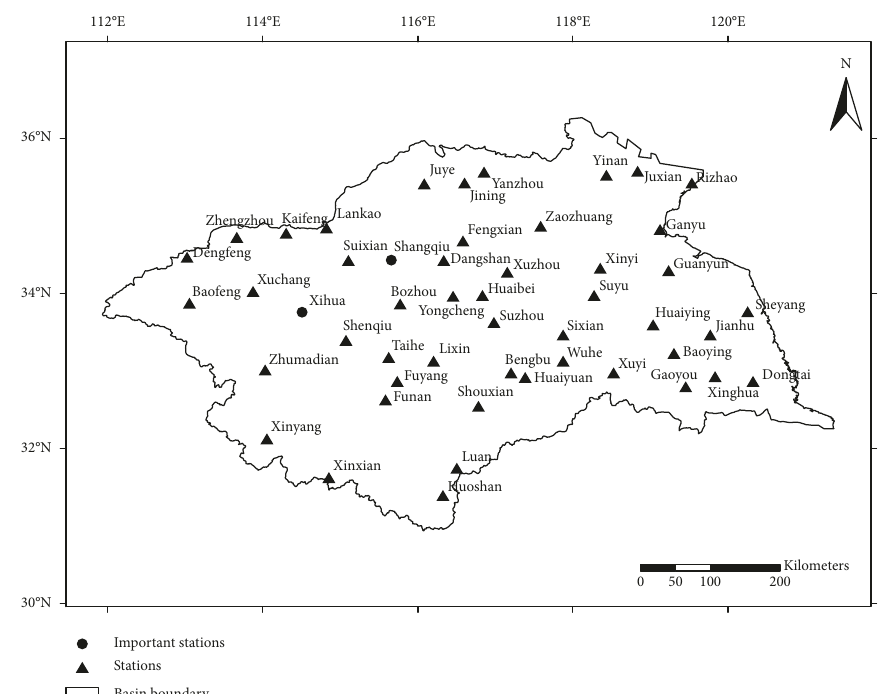
Figure 1: Distribution of meteorological stations in the Huai River basin (HRB). Xihua station and Shangqiu station are labled as “important stations,” which will be used in the frequency analysis in Section